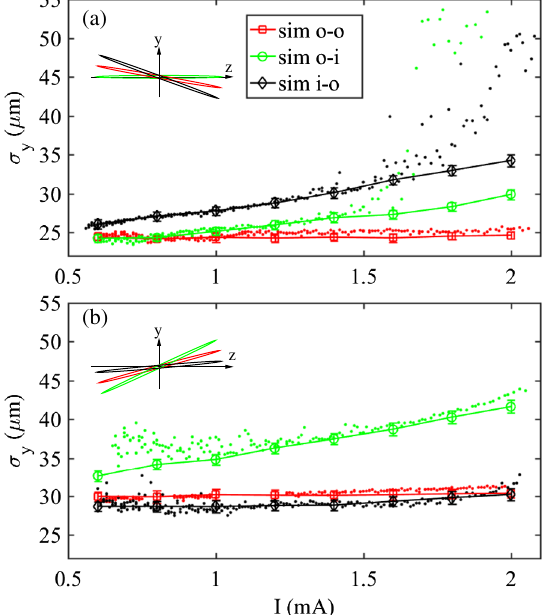
e − lattice lat − ð 0 Þ with the coupling bump set at (a) cp 11 ¼ 0 and (b) cp 11 ¼ − 10 k. Small dots: data. Larger symbols with error bars: simulation. Red: both scrapers out (o-o). Black: top scraper inserted (i-o). Green: bottom scraper inserted (o-i). The cartoons indicate the beam tilts at 0.6